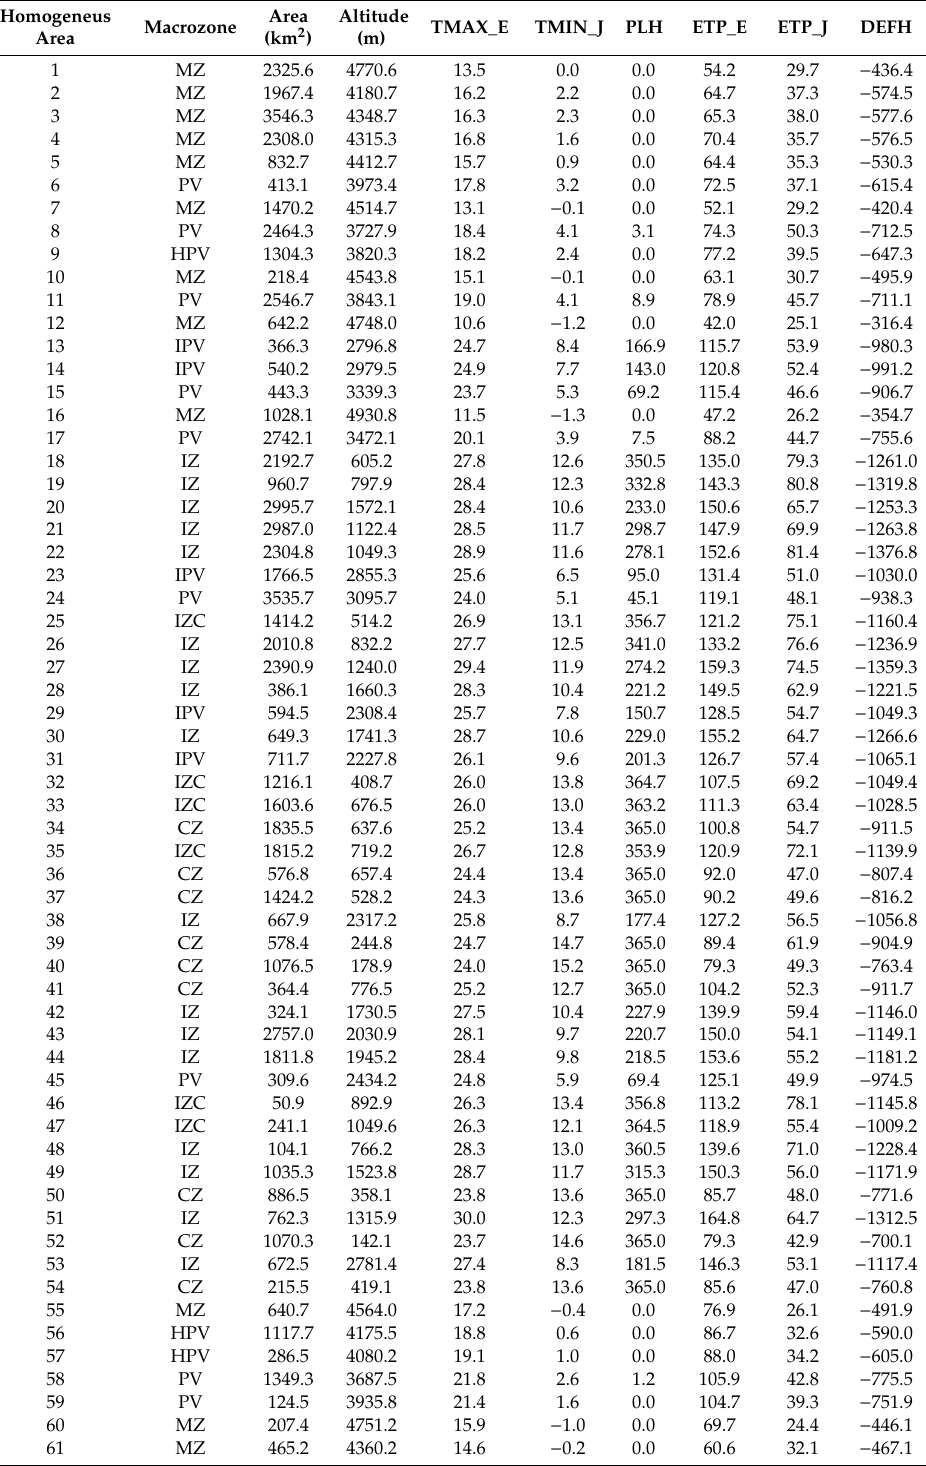
Table 4. Topoclimate characterization of every homogeneous area obtained, beginning with the topoclimate zoning of the Atacama region, where TMAX_E is maximum temperatures in January ( ◦ C), TMIN_J is Minimum temperatures in July ( ◦ C), PLH is the Frost free period (days), ETP_E Evapotranspiration in January (mm month − 1 ), ETP_J Evapotranspiration in July (mm month − 1 ) and DEFH Water deficit (mm). The indicated macrozones are: MZ, mountain range zone; PV, pre-mountain range valley; HPV, high pre-mountain range valley, IPV, pre-mountain range with inside influence; IZ, inside zone; IZC, inside zone with coastal influence; and CZ, coastal